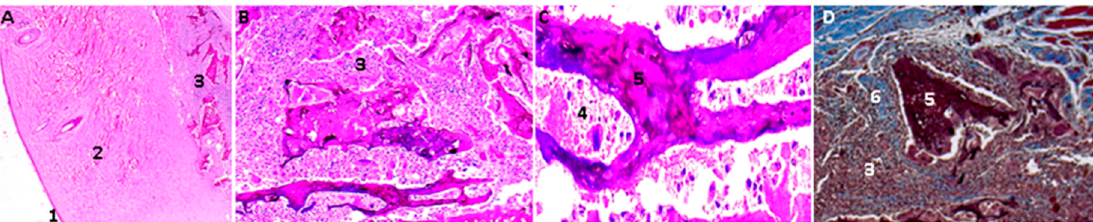
Figure 11. Scaffolds of CS/GO 1% implanted in rat skin. In the images ( A , B ), the scaffolds are appreciated at 4 × and 10 × , respectively, using the Hematoxylin-Eosin Technique. In the image ( C ) at 40 × , the film is observed in the process of resorption and surrounded by a mixed inflammatory infiltrate. The image ( D ) at 10 × is made using Masson’s trichromacy technique. In this image, a fibrous tissue capsule is seen surrounding the scaffold of CS/GO. 1: Epidermis, 2: Dermis. 3: subcutaneous cellular tissue (implantation zone), 4. Mixed inflammatory infiltrates, 5. CS/GO 1%, 6: Fibrous